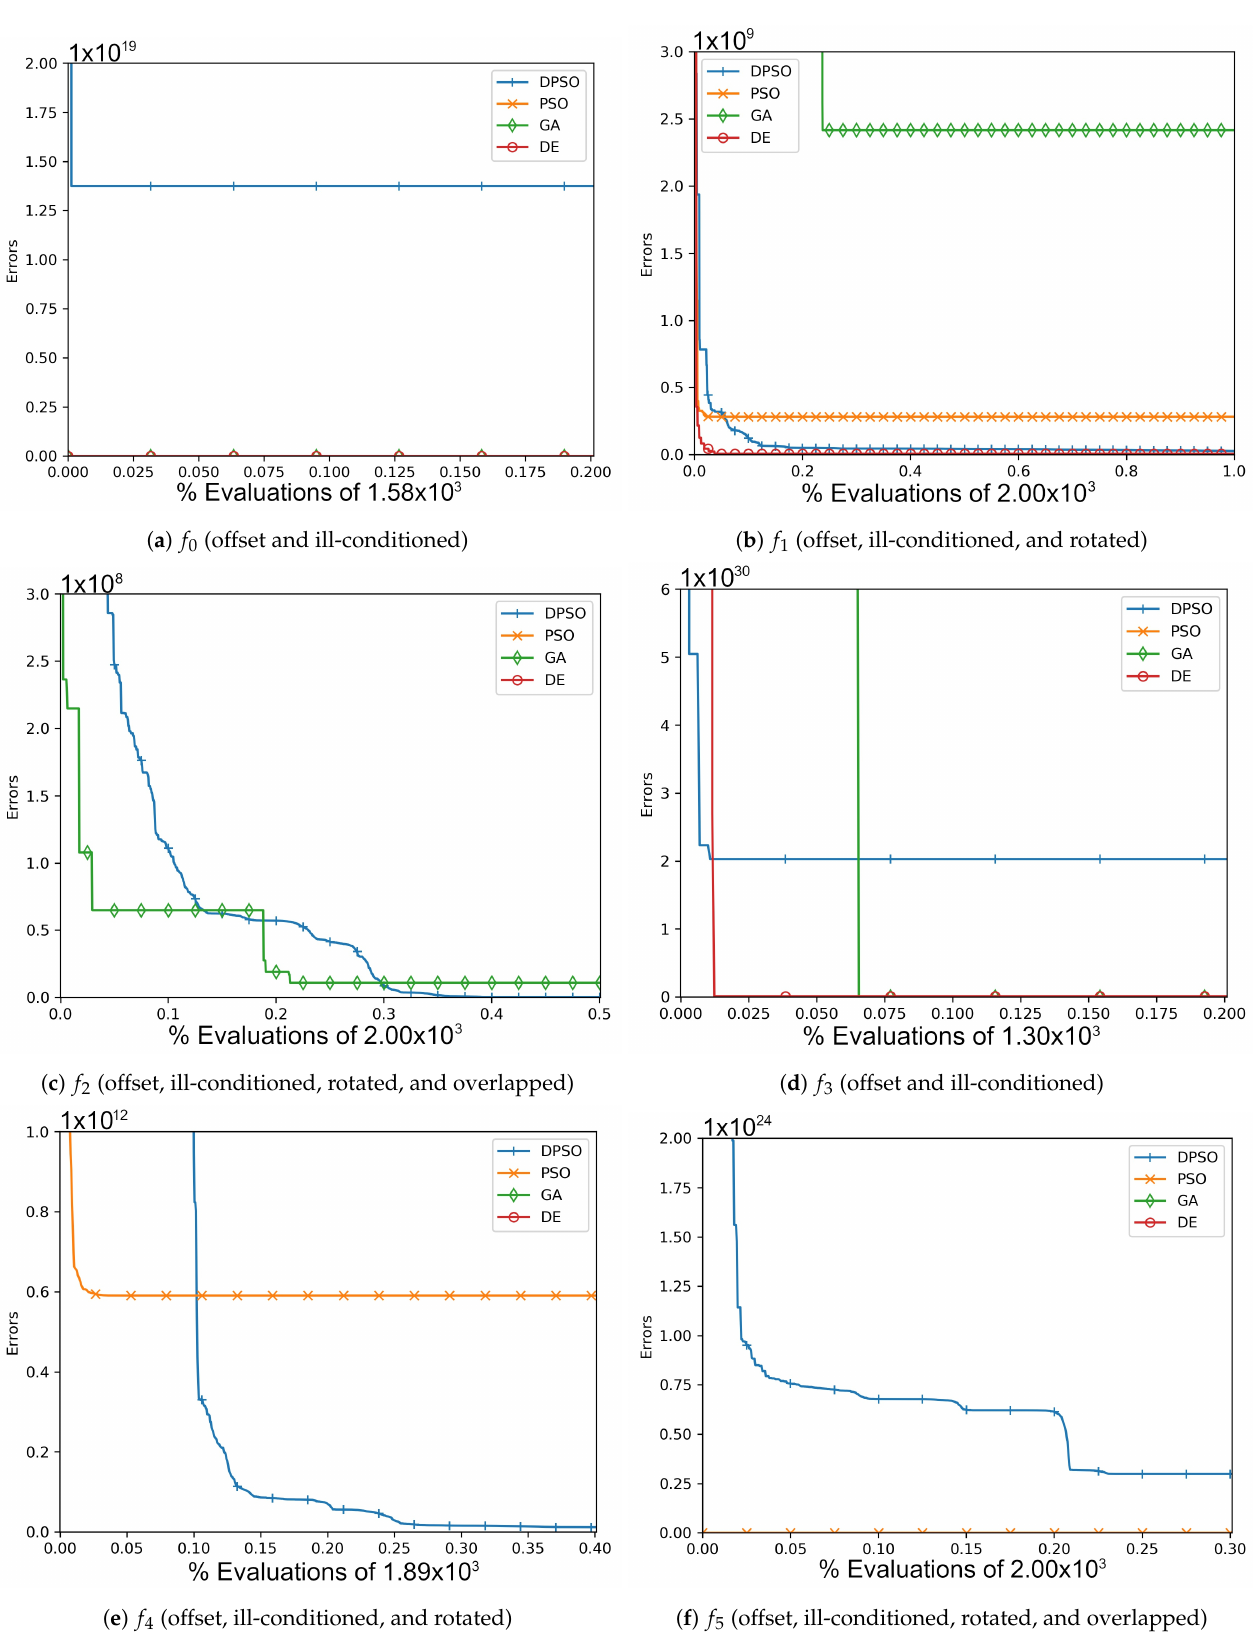
Figure A3. The average In-Sample ( f 0 , f 1 , f 2 ) and Elliptical ( f 3 , f 4 , f 5 ) global best results over time for 21